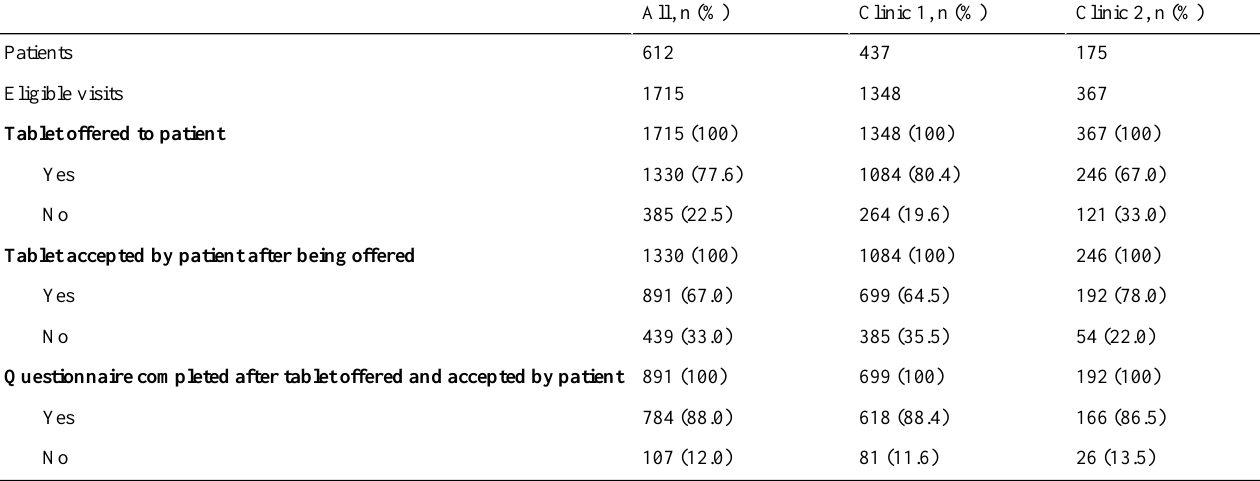
Table 1. Tablet uptake and